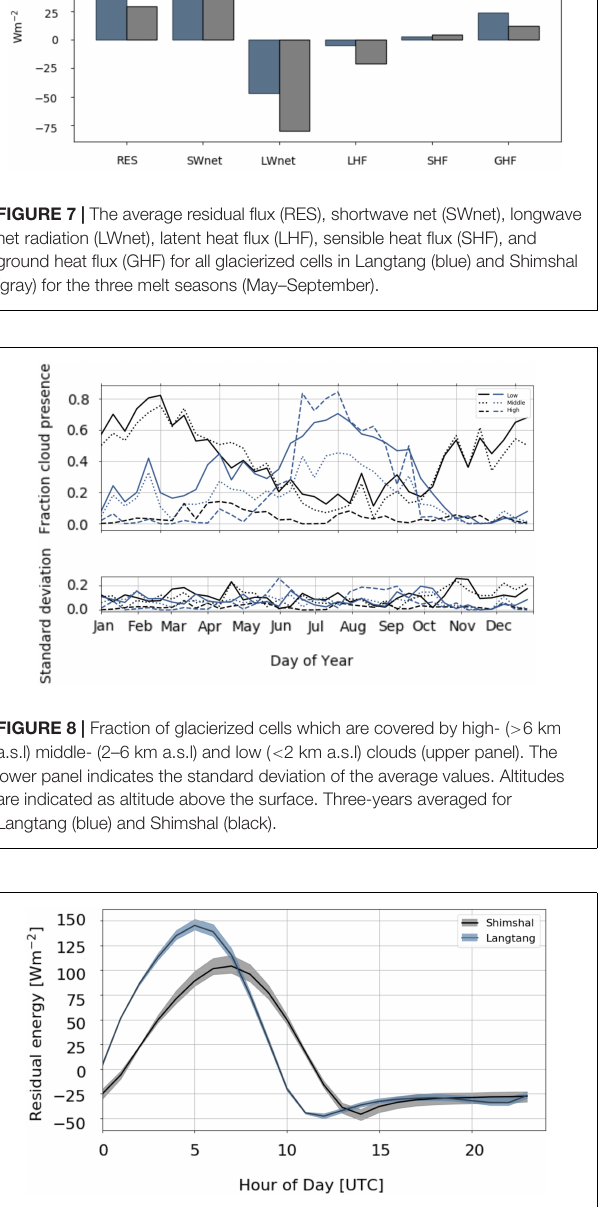
are larger in the Karakoram than in central Himalaya, and we note that the differing catchment sizes of Shimshal and Langtang may impact the altitudinal gradients presented.